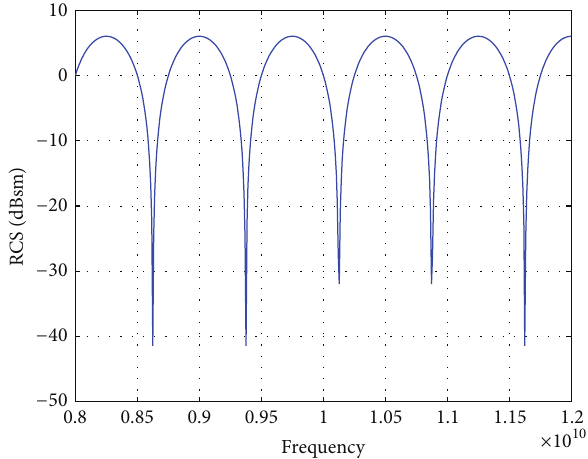
Figure 13: Maximum radar range dependency on RCS.